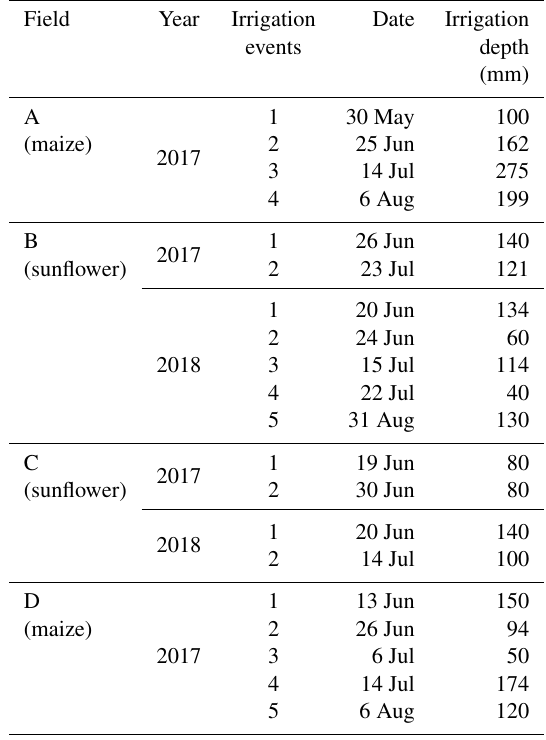
Table 1. Irrigation scheduling for the Shahaoqu experimental fields in 2017 and